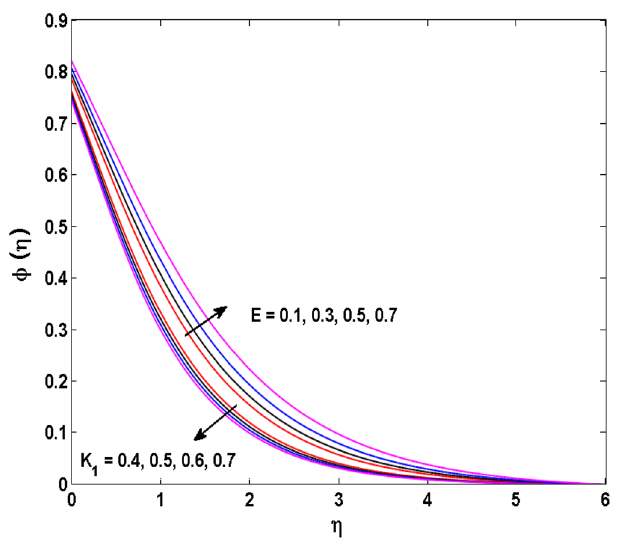
Figure 16. Variations of K 1 and E to φ (η)